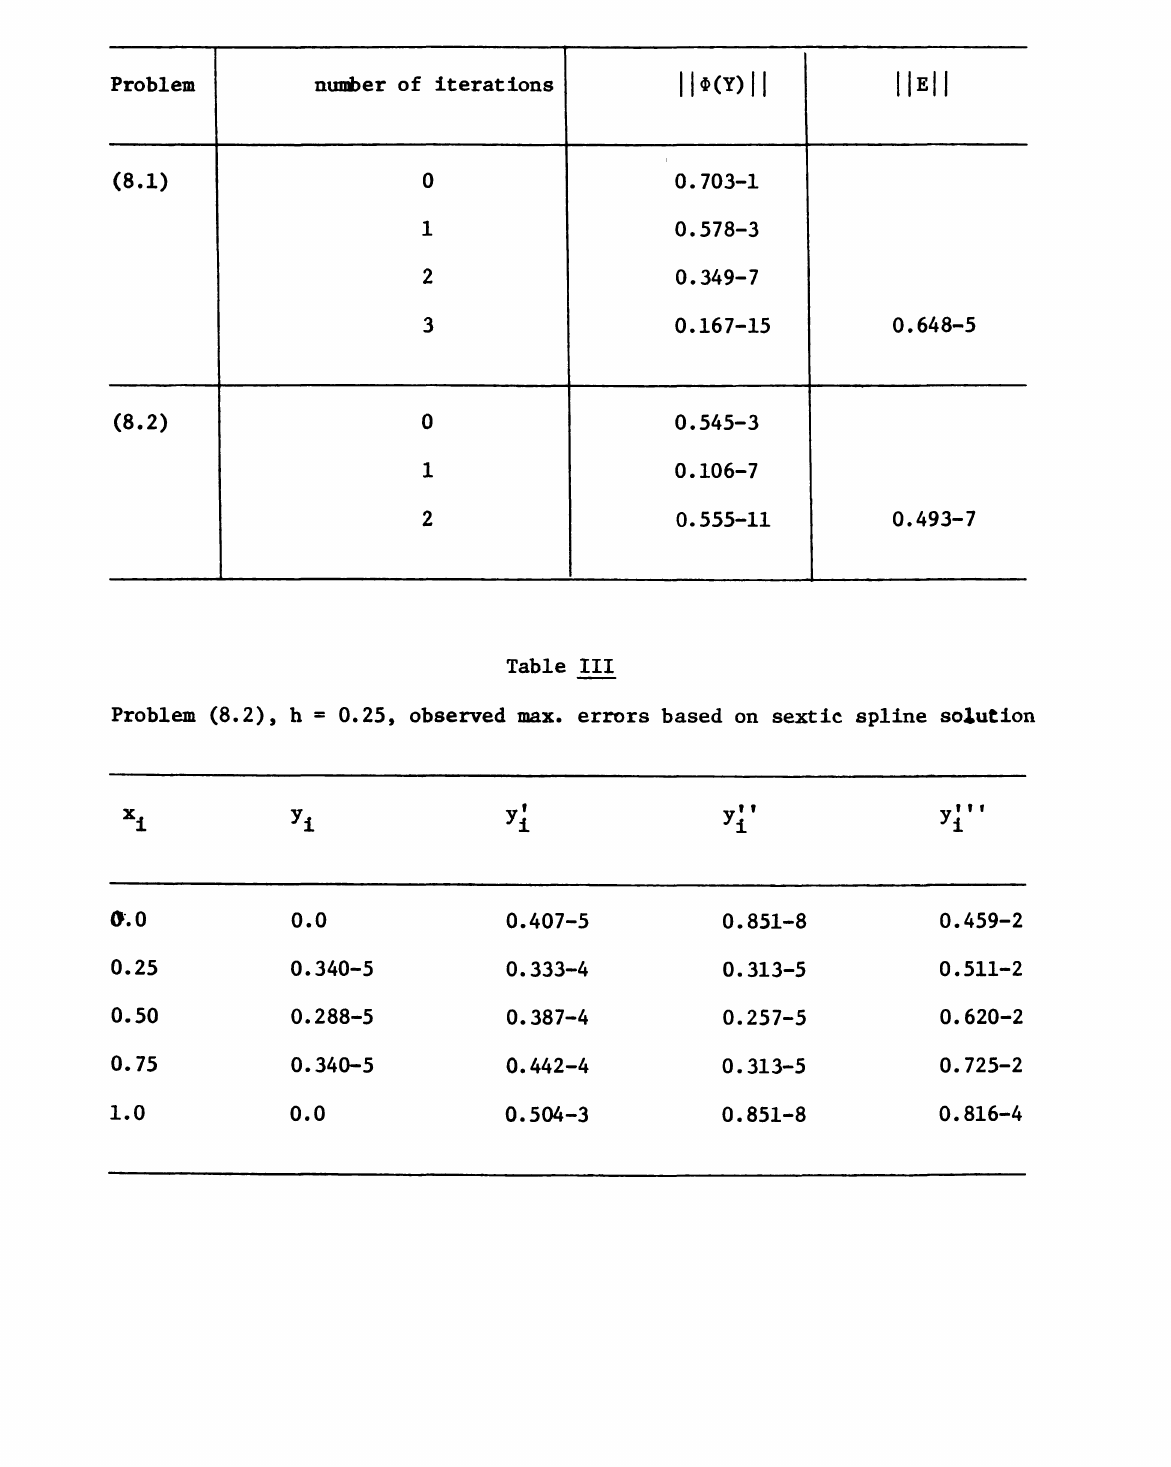
1/8, observations based on quintic spline solution